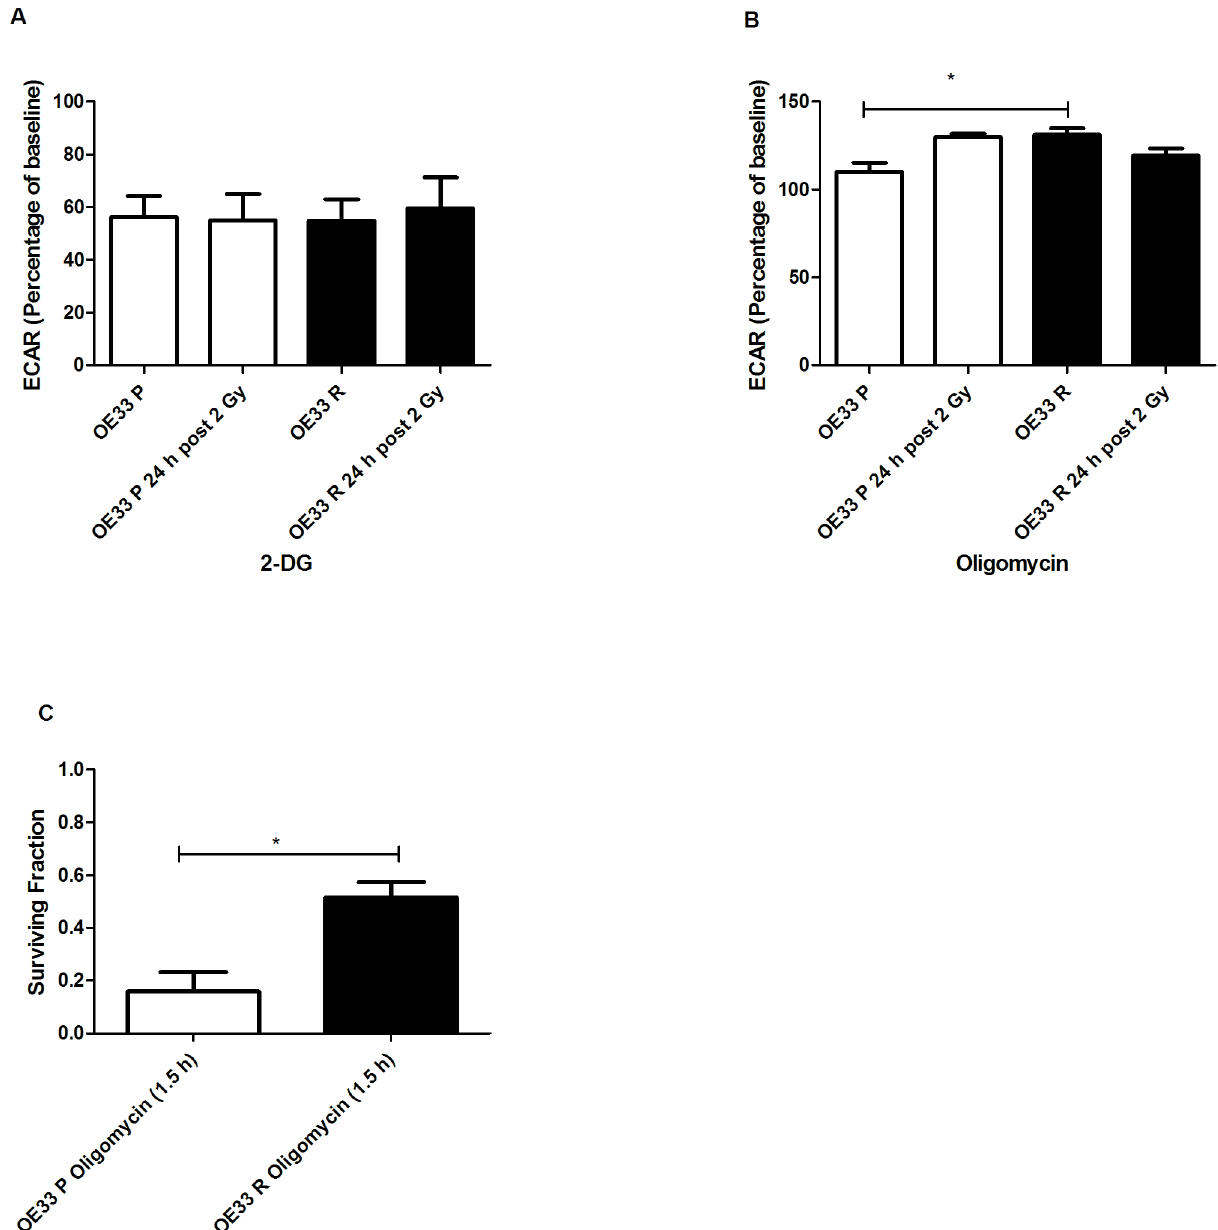
Figure 5. OE33 R cells are more metabolically robust. ( A ) OE33 P and OE33 R cells display similar sensitivities to the glycolytic inhibitor 2- deoxyglucose (55 m g/mL). ( B ) ECAR is significantly increased in OE33 R cells following oligomycin treatment (2 m g/mL), when compared to OE33 P. ( C ) OE33 R cells have significantly enhanced clonogenic survival following treatment with oligomycin (2 m g/mL) for 1.5 h, when compared to OE33 P cells. Data are presented as mean 6 SEM from at least 3 independent experiments. Statistical analysis was performed by 2-tailed Student’s t -test, * P , 0.05.